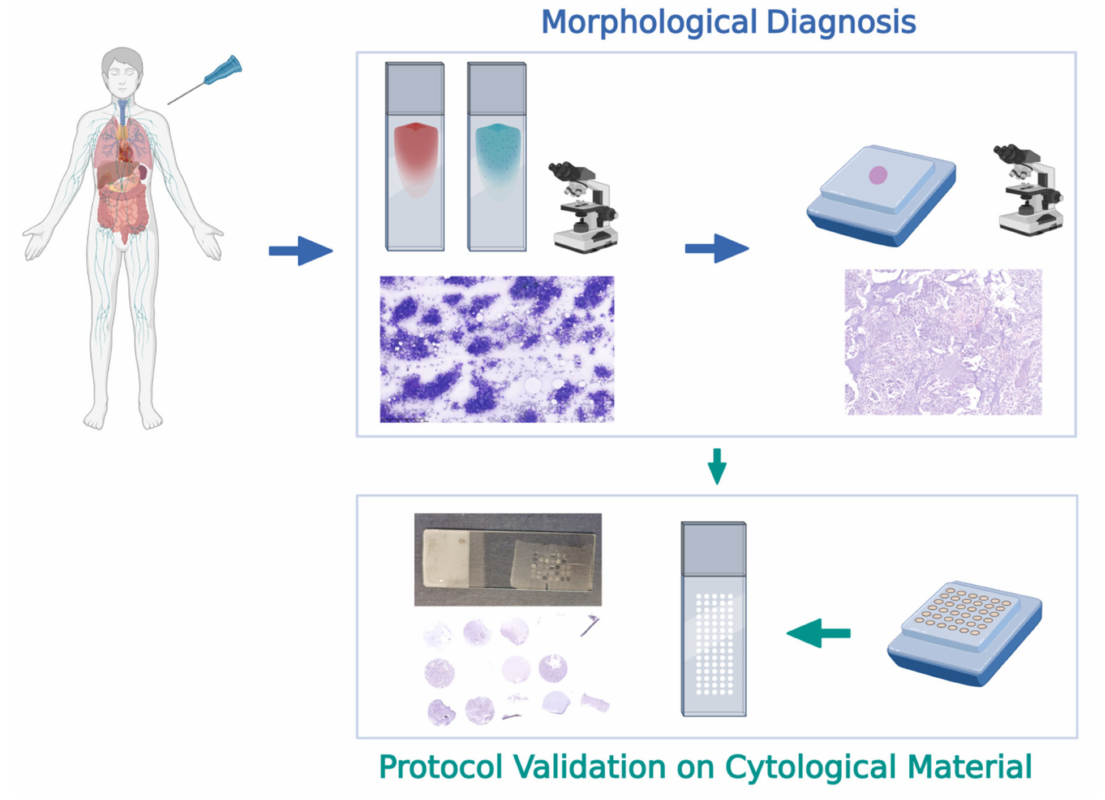
Figure 3. Flow chart of a novel approach for biomarker testing validation on cytological material, based on the use of cell-block-derived tissue microarray